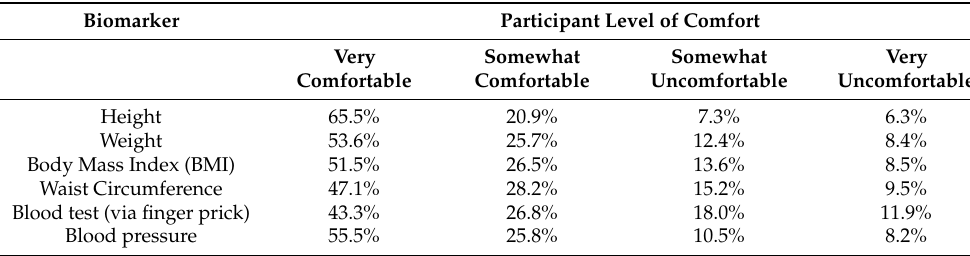
Table 4. Dog owners’ (n = 1028) self-reported comfort of having biomarkers measured at a veterinary clinic.